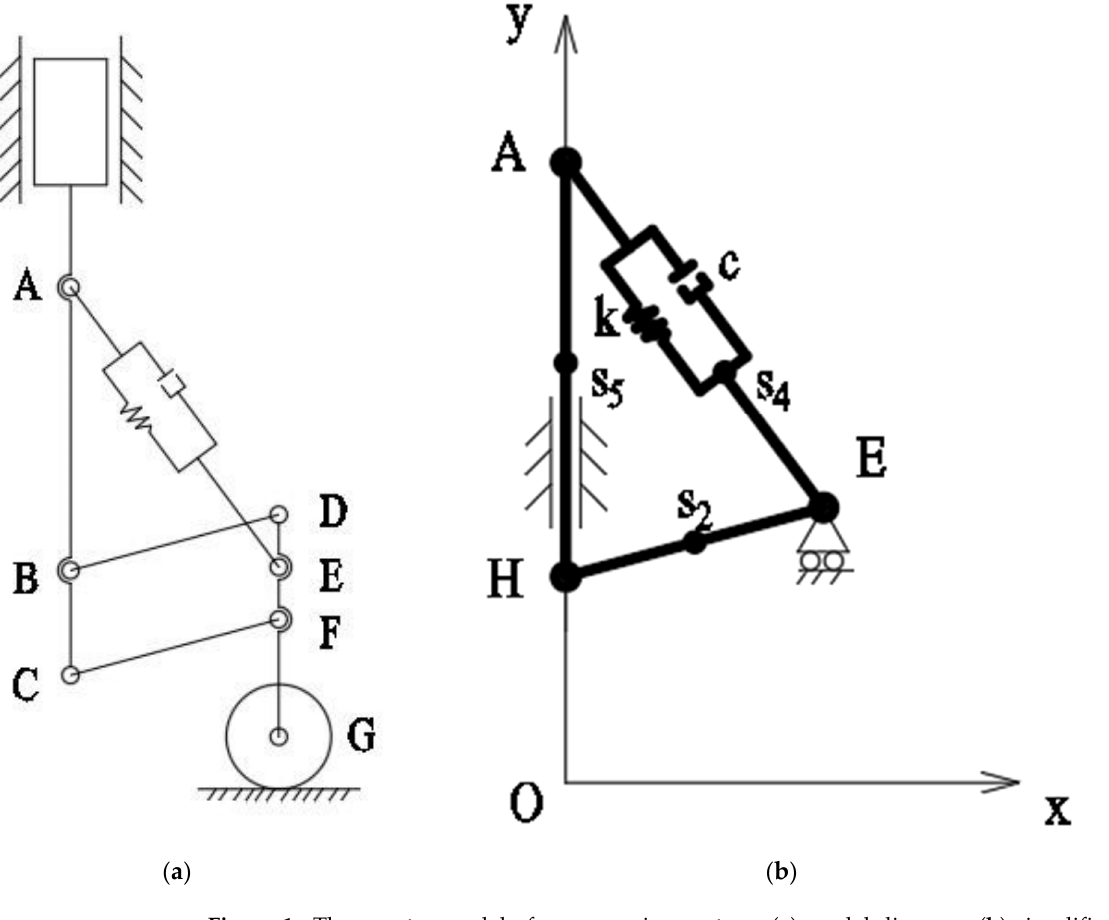
Figure 1. The quarter model of a suspension system: ( a ) model diagram; ( b ) simplified model diagram. (A–H indicate the hinge connection points between the parts).